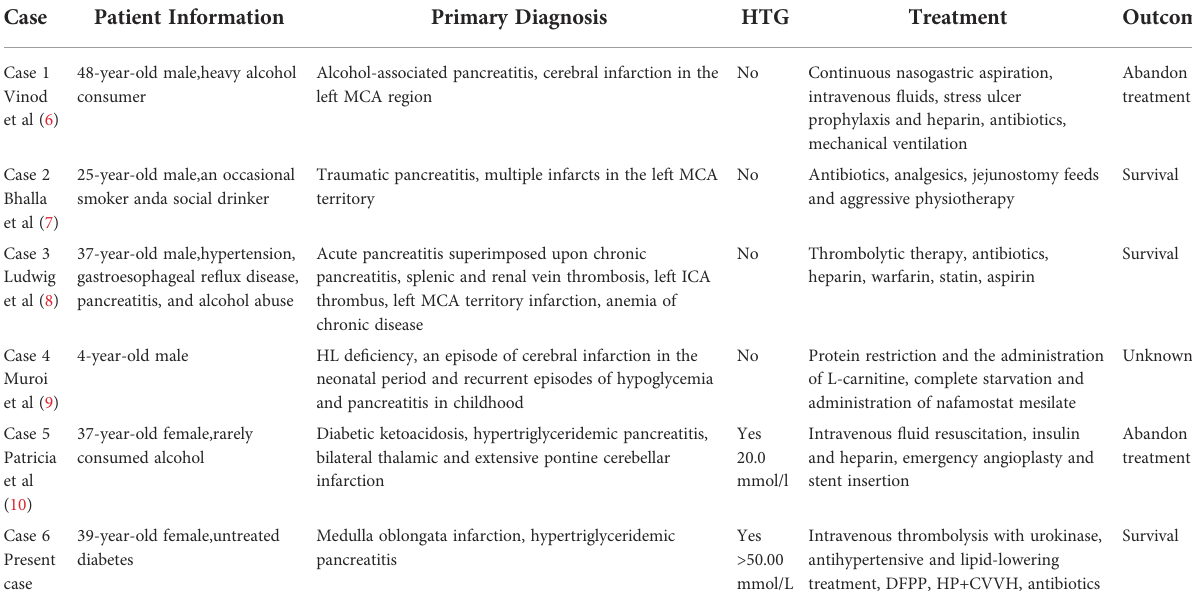
TABLE 1 Details of patients with stroke and pancreatitis.